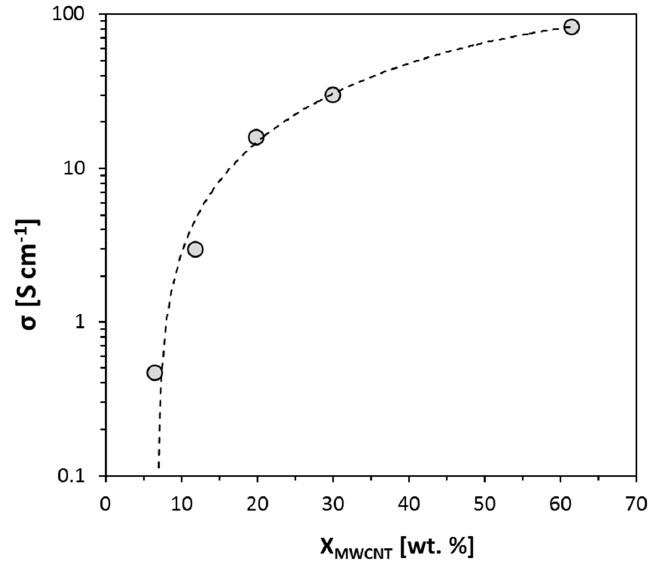
Figure 3. Electrical conductivity of films MSH-0 to -4 (Table 2) with various concentrations of MWCNTs on a dry basis. Table 3. Thickness ( t ), mass ( m ), sheet resistivity ( R s ), electrical conductivity ( σ ), capacitance ( C ), and